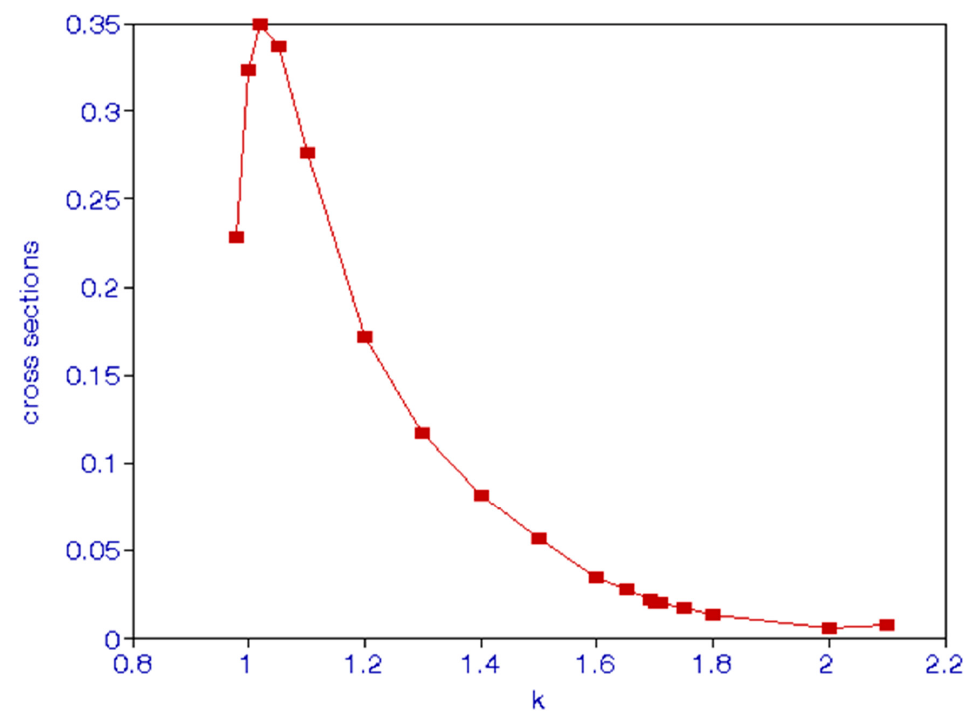
Figure 3. (Color online) Total 1 S to 4 S excitation cross sections ( π a 2 k (Ryd).